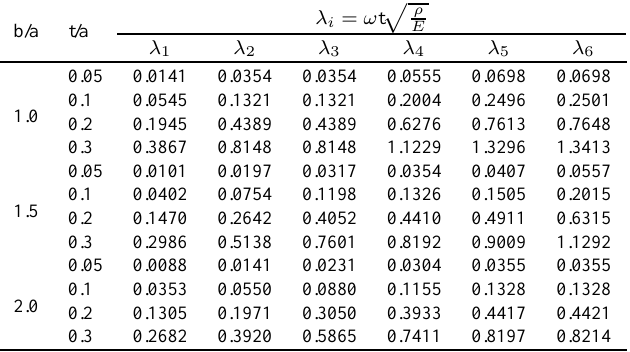
Table 1 The first six natural frequency parameters of thick simply supported plates for